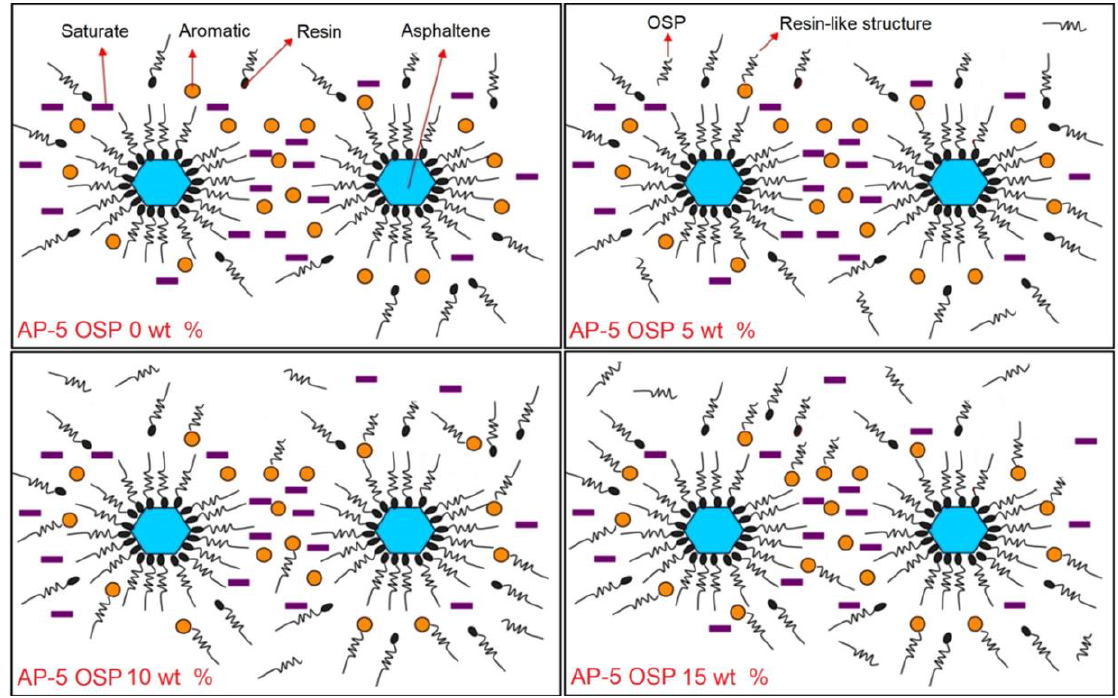
Figure 7. Adsorption of aromatic components on oyster shell powder surface at different doses (e.g., 0, 5, 10, 15 wt %) and creation of resin-like structures.